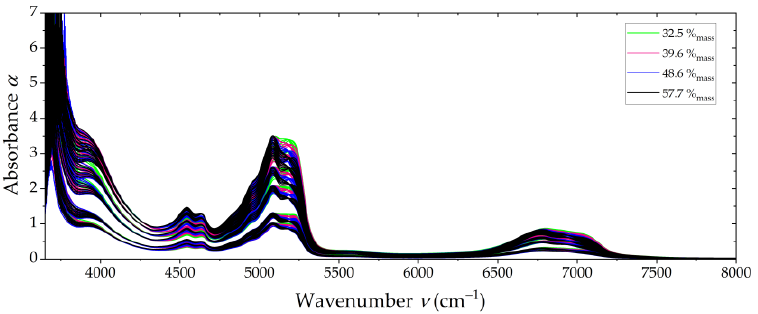
Figure 5. Absorbance spectra of all calibration measurements over the wavenumber. Spectra are color coded with respect to the film concentration of urea in water 𝑐 and contain all 𝑇 and 𝛿 var- iations.